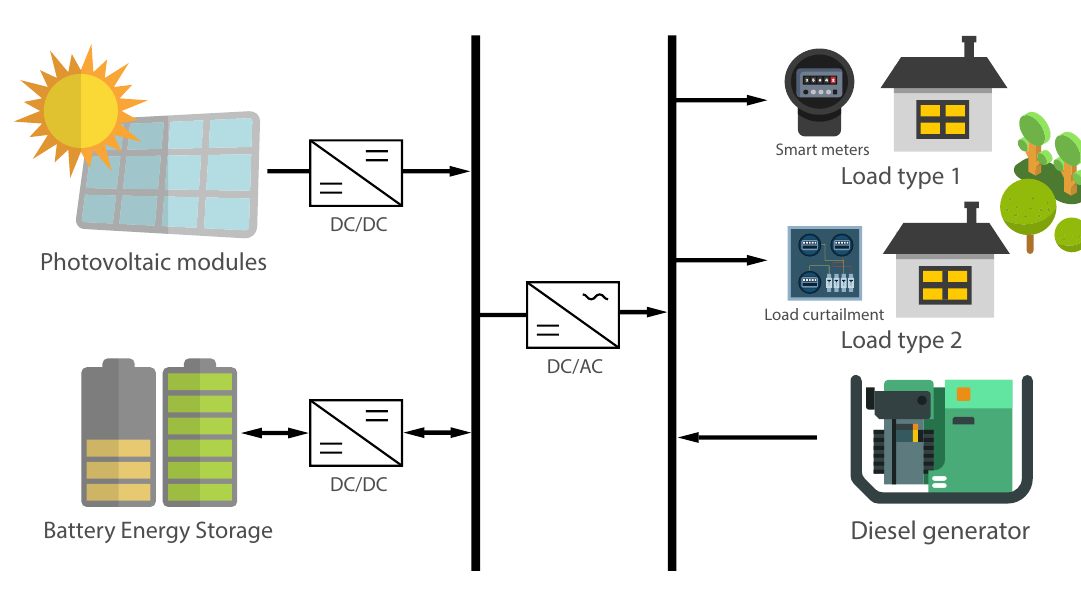
Figure 2. Architecture of the islanded/isolated microgrid of the case study.